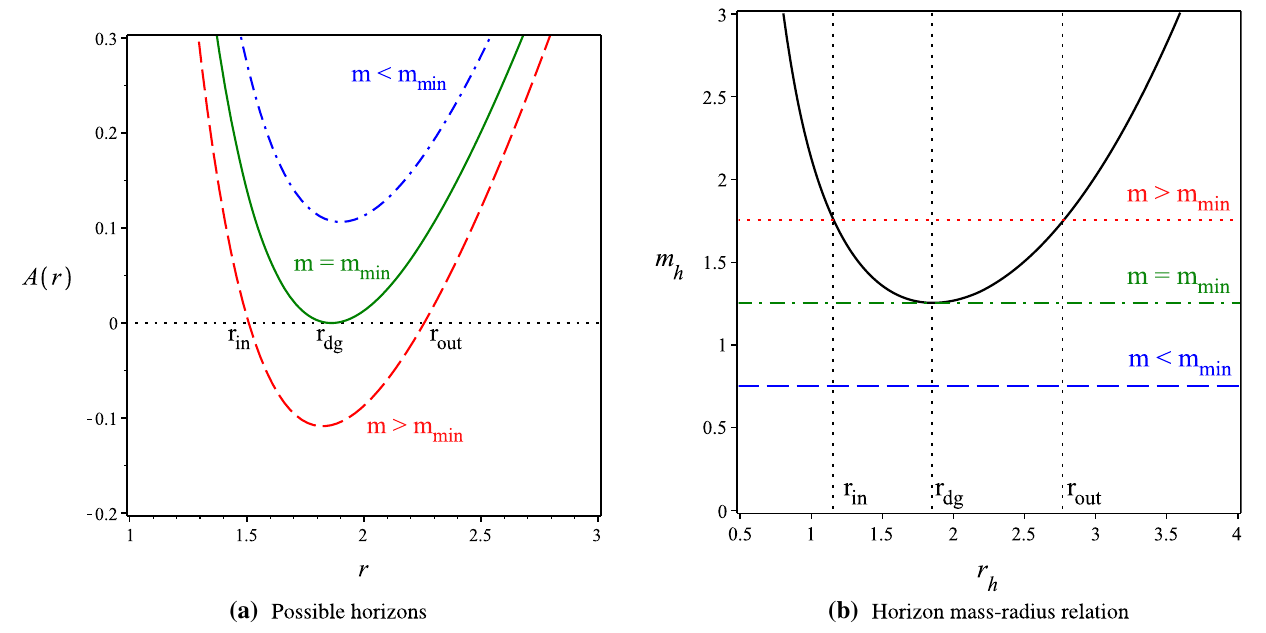
Fig. 1 Schematic plots of possible horizons: a typical behaviour of the function A ( r ) given by (89). b The horizon mass-radius relation (93) with the minimum mass (91) at which the two horizons coincide at the